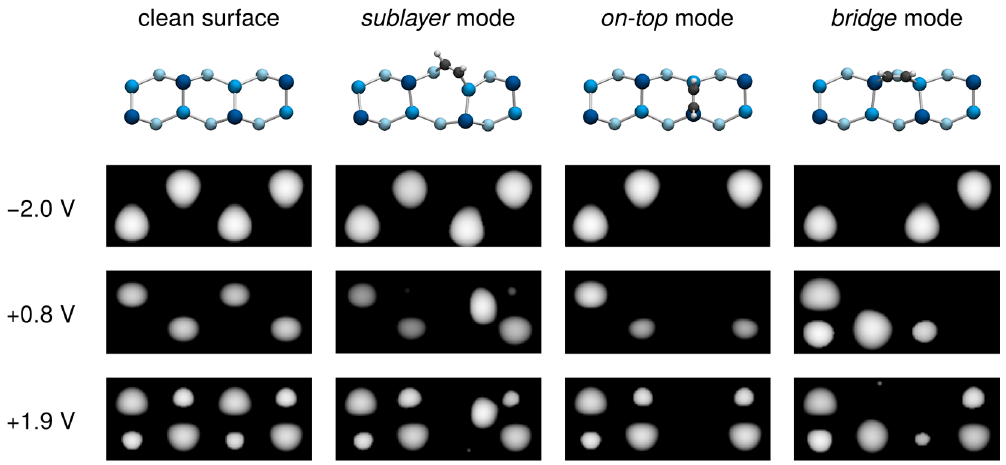
Figure 5. Simulated STM images of a clean surface and the adsorption modes sublayer, on-top, and bridge at bias voltages of U = − 2.0, +0.8 and +1.9 V. The sublayer mode can only be identified at positive voltage from the displaced signal of the Si down atom to which the molecule is bonded. Color coding of Si atoms: dark blue (Si up ), medium blue (Si down ), light blue (Si sub ).